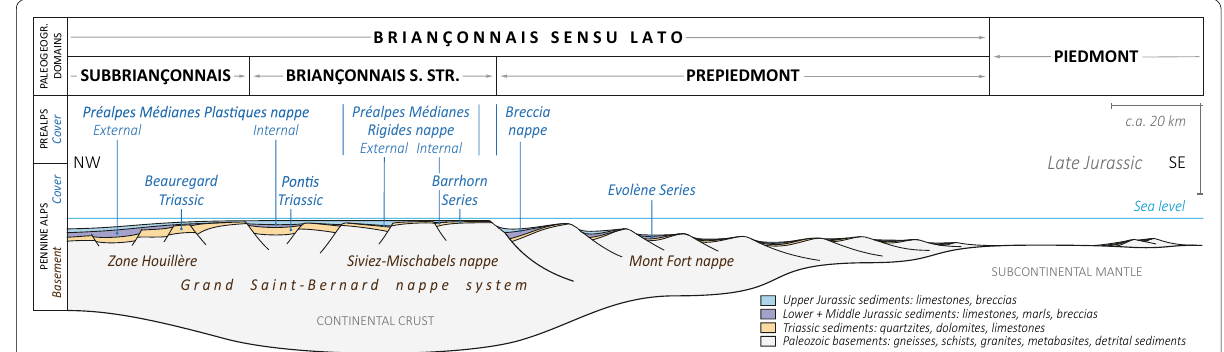
Fig. 3 Late Jurassic transect of the Briançonnais s.l. paleogeographic domain in SW Switzerland (after i.a. Trümpy 1960; Baud and Septfontaine 1980; Sartori 1990; Septfontaine 1995; Plancherel et al. 1998; Mohn et al. 2010, 2012; Decarlis et al. 2017a). The distance between the Préalpes Médianes Rigides and the Breccia nappe basins is uncertain and represents a minimal estimate (the domain separating these 2 basins is often referred to as